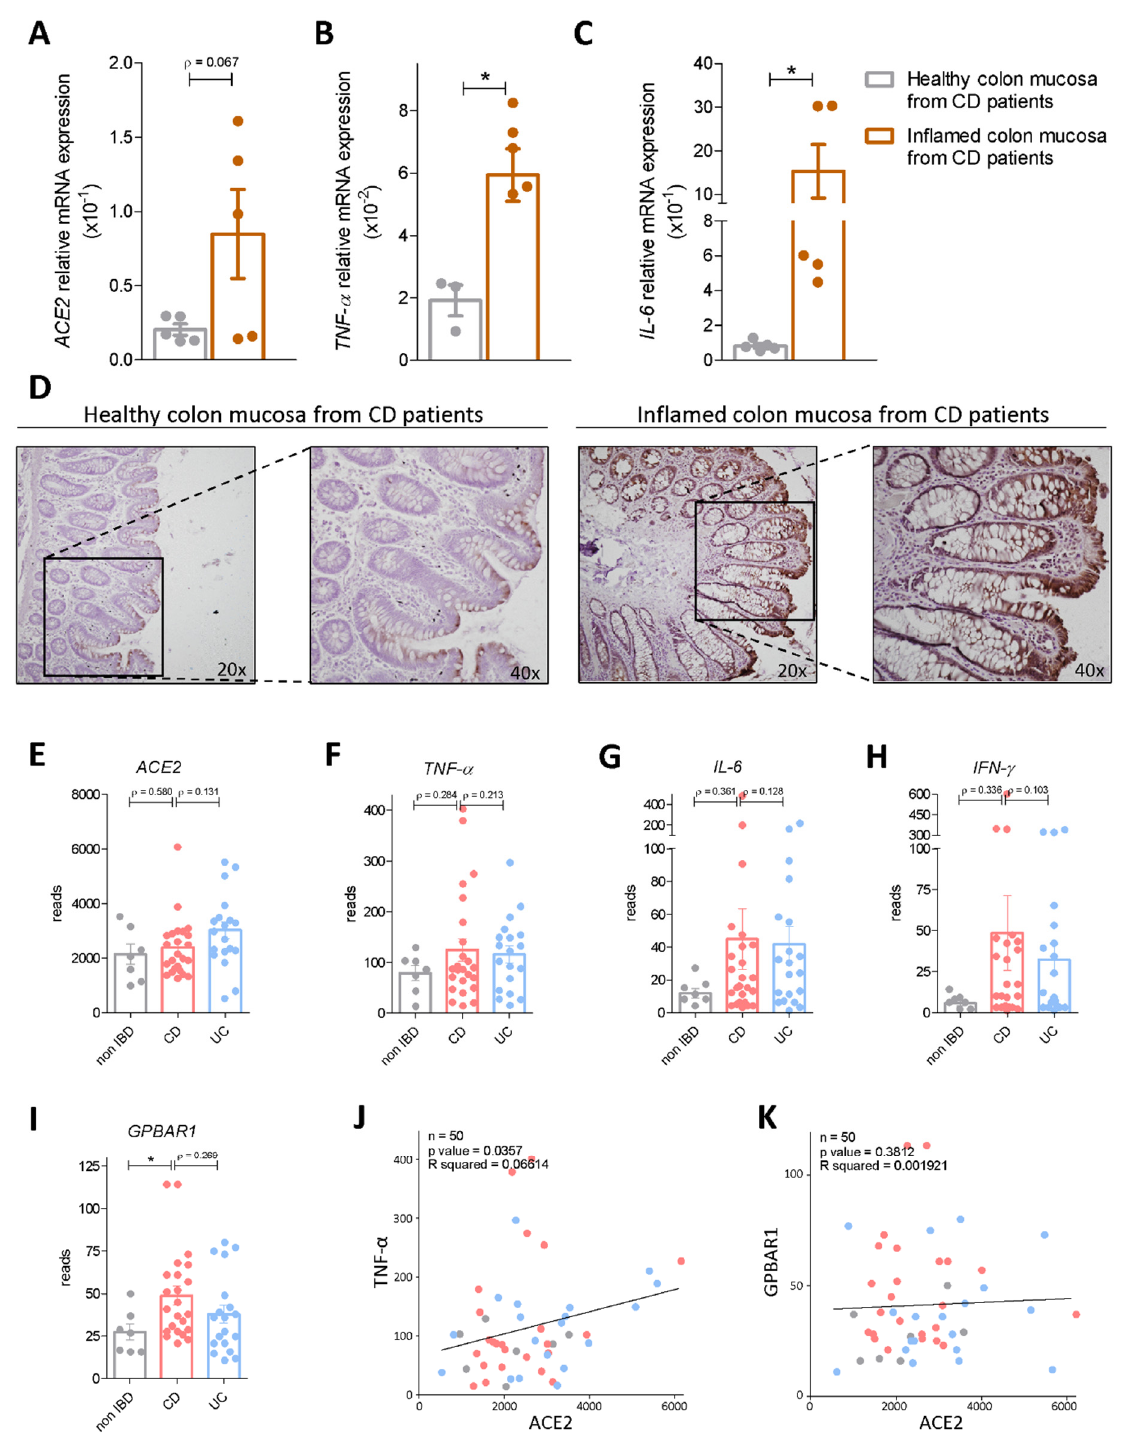
Figure 2. ACE2 mRNA expression in healthy and inflamed colon. The relative mRNA expression of ( A ) ACE2 ( B ) TNF- Α ( C ) IL-6 in colon biopsies from healthy and inflamed colon mucosa from Crohn’s disease ( C , D ) patients. Data are normalized to GAPDH mRNA. Results are the mean ± SEM of 5 patients per group; * p <0.05. ( D ) Immunohistochemistry analysis of ACE2 expression in non-inflamed and inflamed colon samples obtained from CD patients (magnification 20× and 40×). ( E–I ) RNA-seq analysis of colonic biopsy samples from HMP2 project CD, UC and non-IBD patients. Each dot represents a patient. Gene profile expression of ( E ) ACE2, ( F ) TNF- Α , ( G ) IL-6, ( H ) IFN- γ and ( I ) GPBAR1. ( J , K ) Correlation graphs between ( J ) TNF- α and ACE2 expression and ( K ) GPBAR1 and ACE2. * p < 0.05.